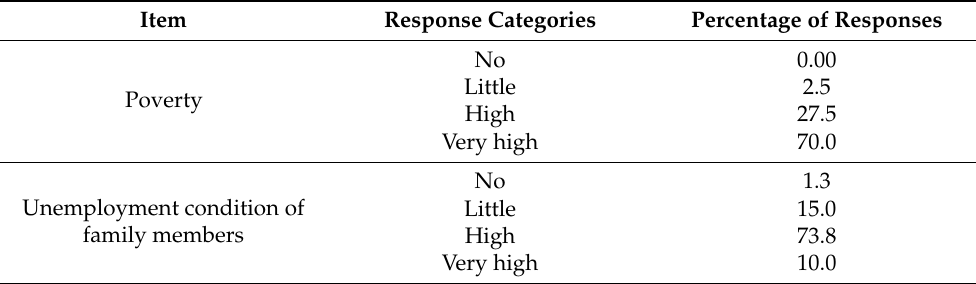
Table 2. Categorization of the responses according to the roots of being child